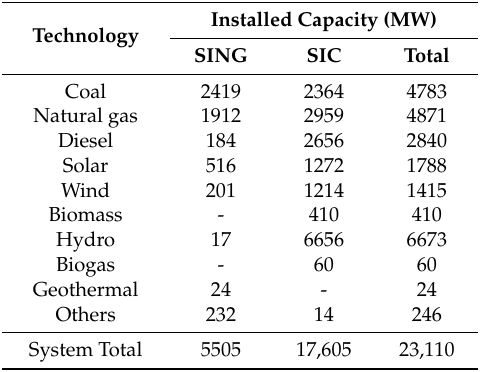
Table 1. Generation mix of Chilean Power Systems in 2017.